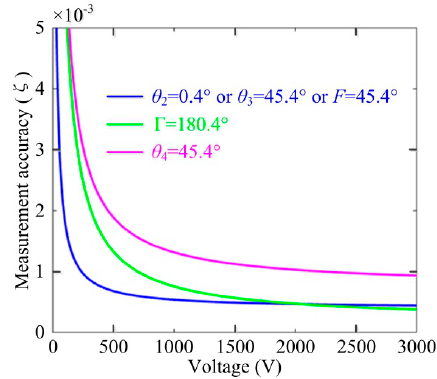
Figure 5. The impact of the optical device axis-angle errors on the OVS measurement accuracy.